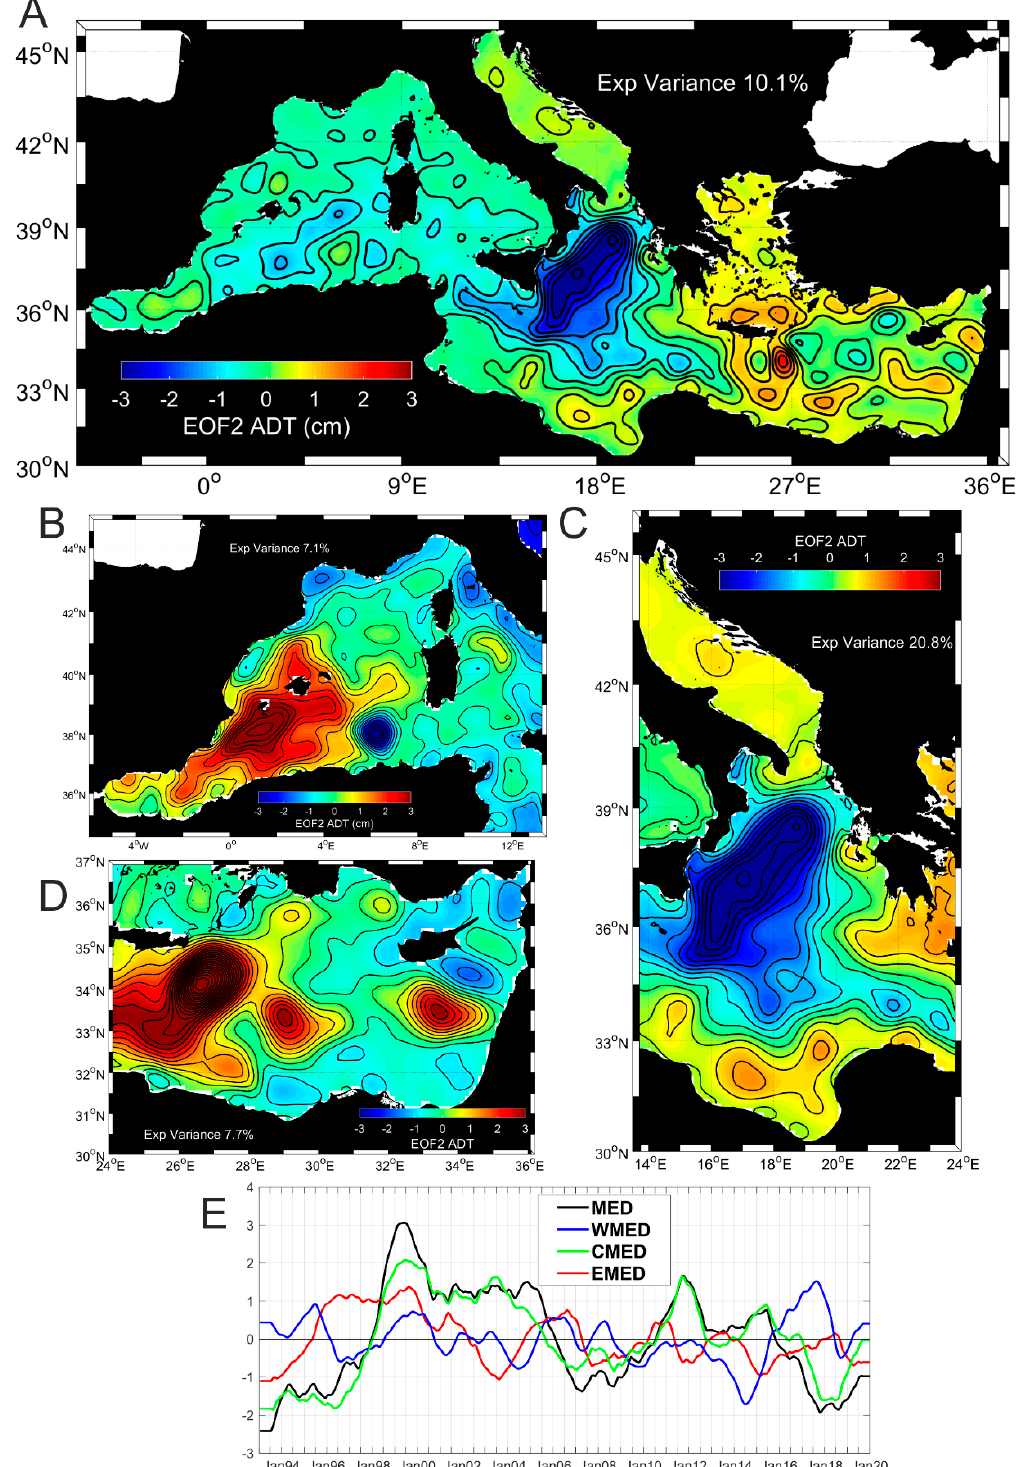
Figure 6. EOF2 of the ADT for the MED ( A ), WMED ( B ), CMED ( C ), and EMED ( D ), and relative PC2s ( E ). The PC2s ( B ) are estimated for the whole MED (black line) and for the three main sub-basins separately (WMED, blue line; CMED, green line; and EMED, red line). The EOF2 field derived from the SST (Figure 7A) explains 13% of the total variance, showing an out-of-phase behavior between the WMED and the EMED (negative values west of 18°E and positive values on the east), a sort of dipolar configuration centered on